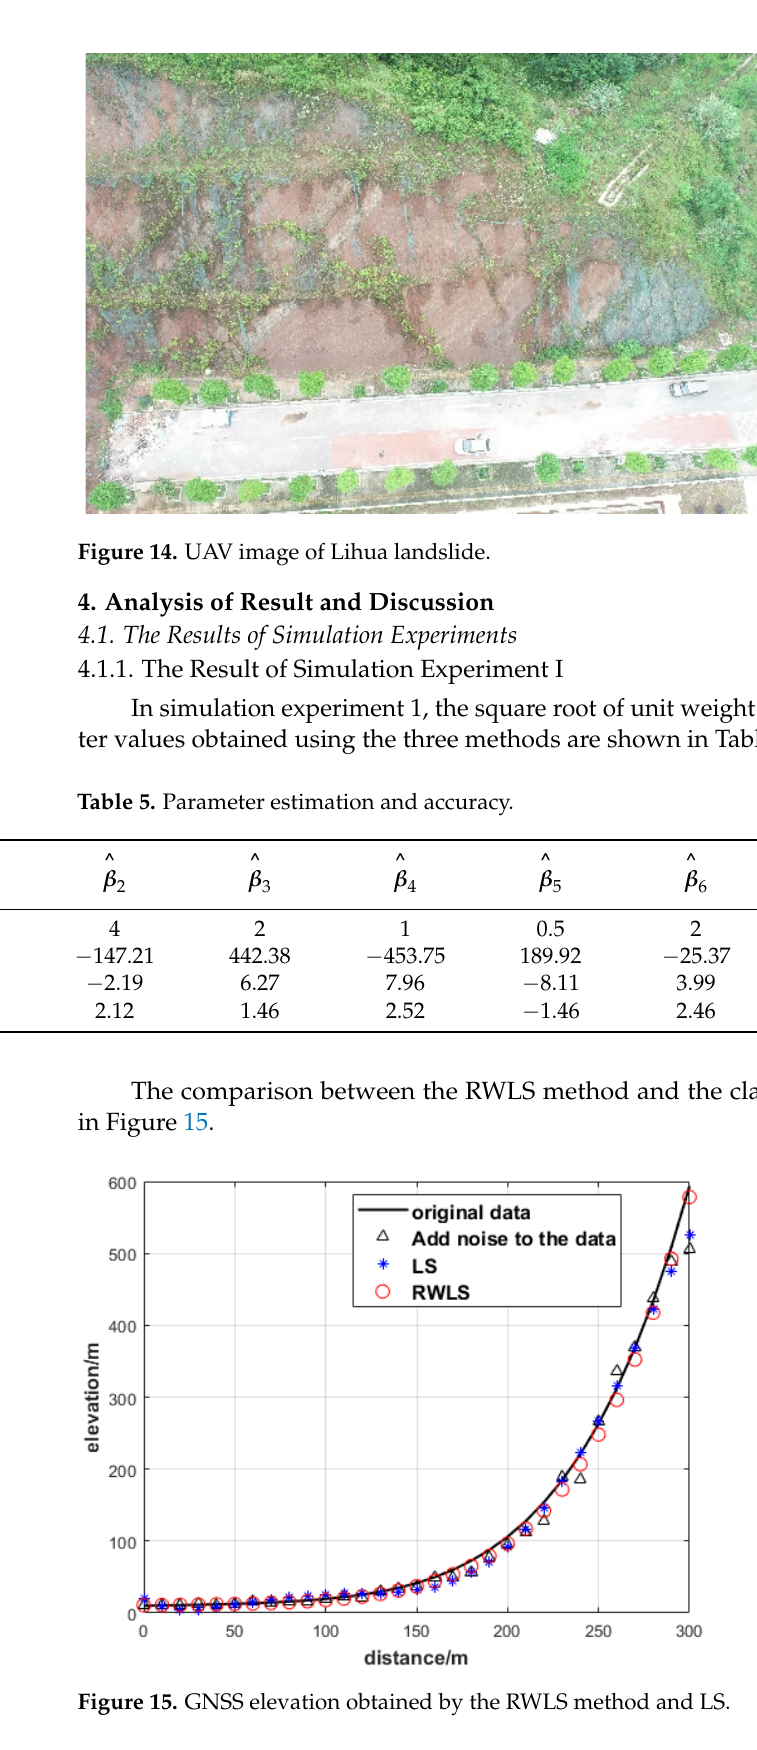
Figure 13. Lihua landslide point cloud of phase 1.